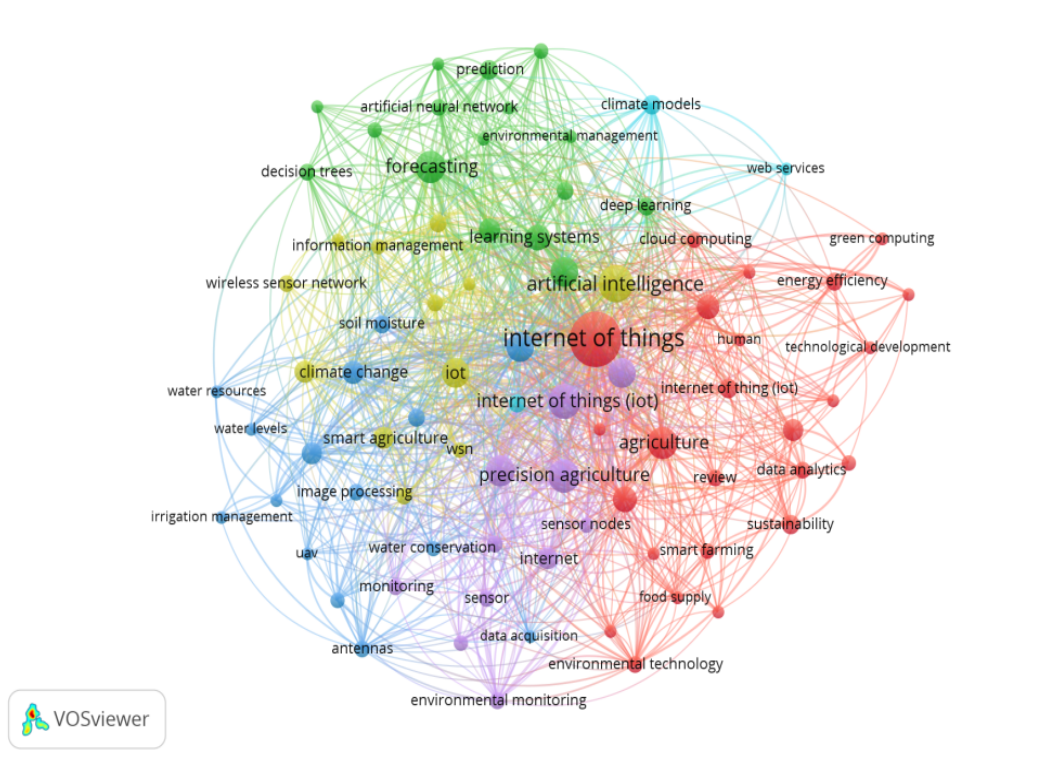
Figure 15. Cluster of co-occurrence of keywords. (Source: www.vosviewer.com (accessed on